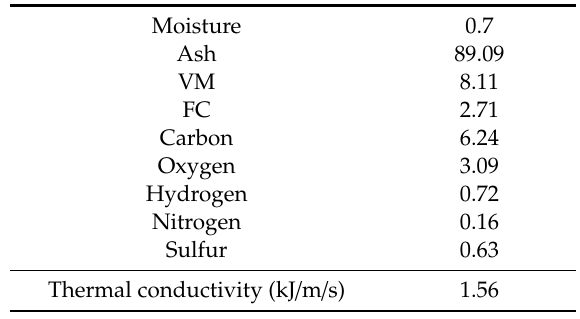
Table 1. Proximate and ultimate analysis (%) [24].